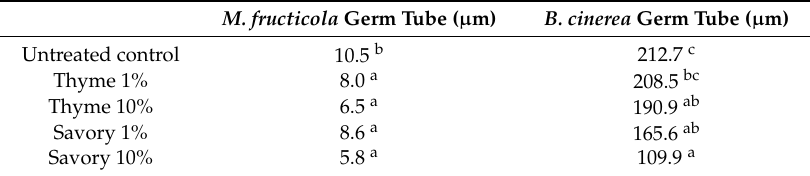
Table 4. Essential oil vapors effect on germ tube length in vitro measured after 36 h at 20 °C for M. fructicola and 20 h at 20 °C for B. cinerea .